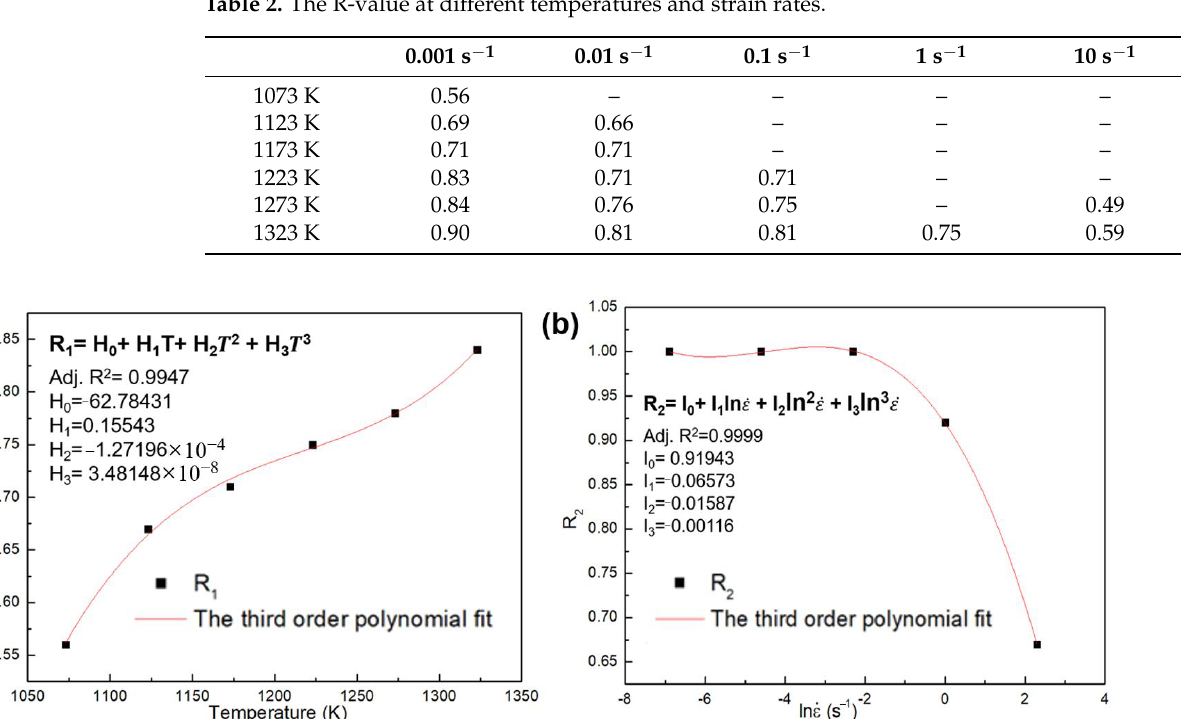
Figure 16. The prediction results of DRX, DRV and TDRV types by R-MAM.